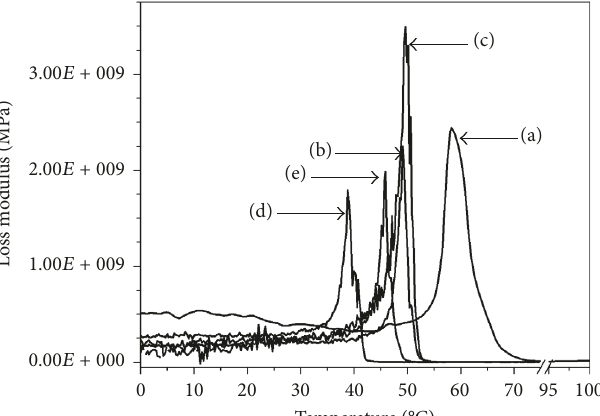
Figure 7: Loss modulus of the PLA-PNSP biocomposites: (a) neat PLA, (b) 5% wt. PNSP defatted, (c) 7.5% wt. PNSP defatted, (d) 5% wt. PNSP untreated, and (e) 7.5% wt. PNSP untreated.